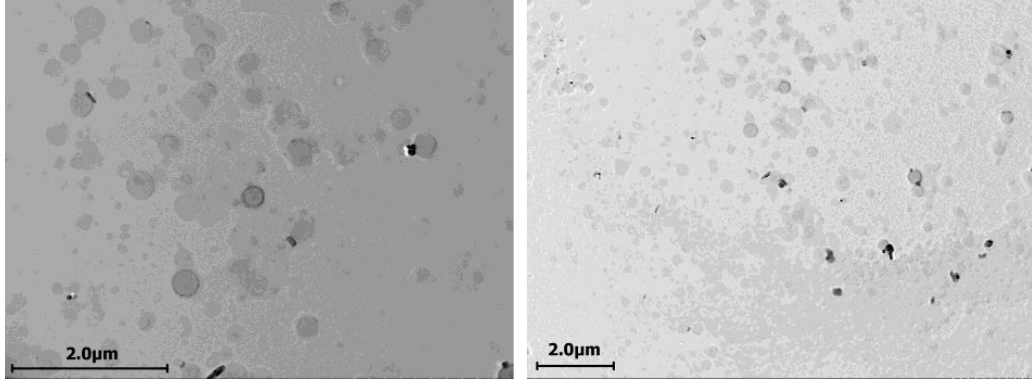
Figure 2. TEM images of CFL16 cerasomes prepared via sol injection method.